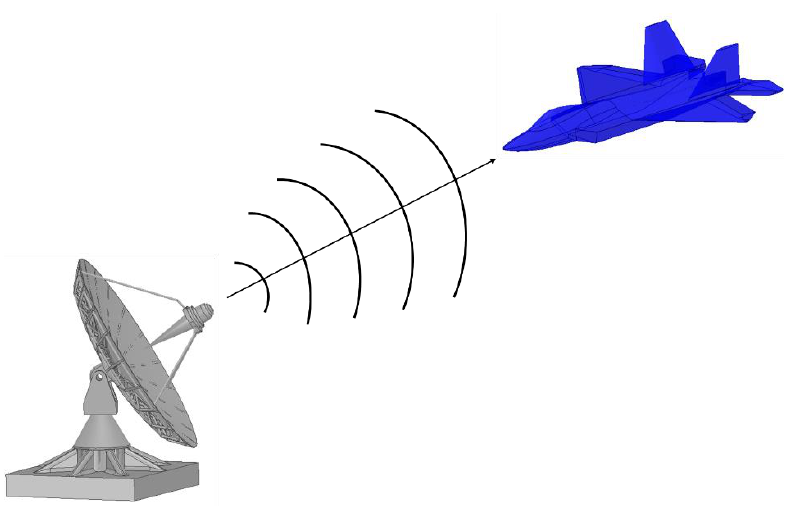
Figure 1. Monostatic THz radar system detecting a target in the near field.